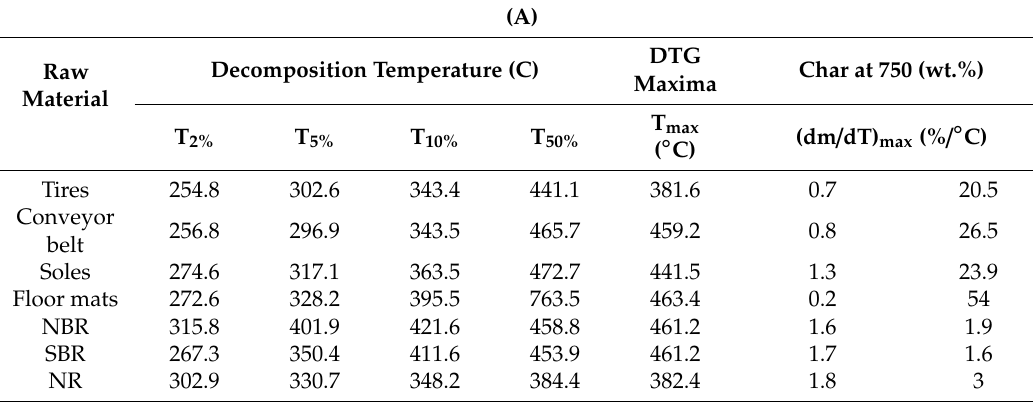
Table 3. ( A ) Thermal decomposition characteristics of rubber waste samples pyrolyzed on a microgram scale in nitrogen atmosphere. ( B ) Composition of the elastomeric material in waste rubber, calculate based on derivative thermogravimetry